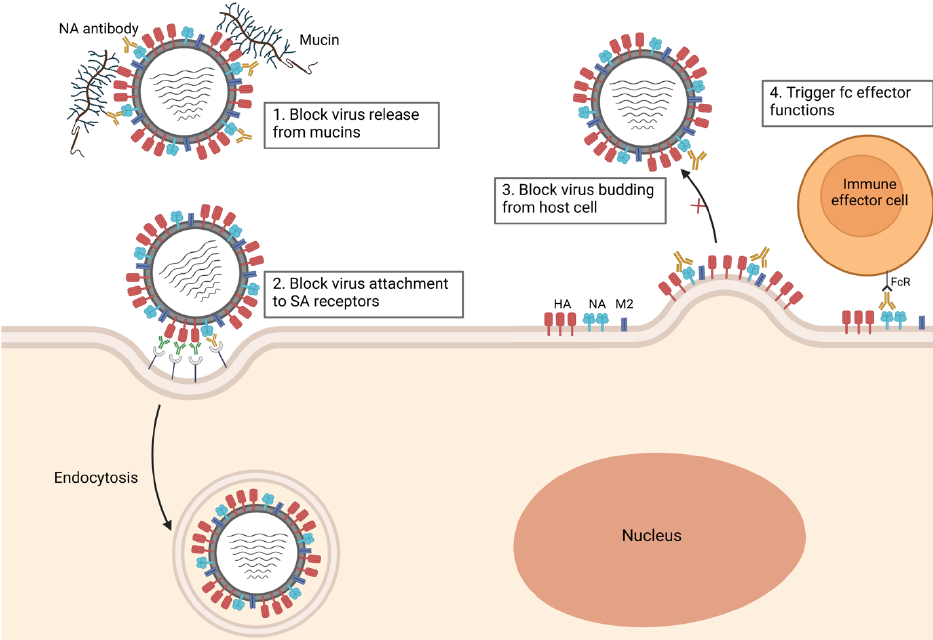
Figure 1. Mechanism of neuraminidase (NA) inhibition by NA-specific antibodies. ( 1 ) NA-specific antibodies prevent viral release from mucins. ( 2 ) Virus attachment to sialic acid receptors (SA) is blocked by NA-specific antibodies as well as hemagglutinin (HA) antibodies. ( 3 ) Virus release from the host cell is blocked by NA antibodies. ( 4 ) NA-specific antibodies trigger Fc effector functions such as antibody-dependent cellular cytotoxicity (ADCC) and antibody-dependent phagocytosis (ADP) through binding with Fc receptors on immune effector cells (natural killer (NK) cells, macrophages, and dendritic cells).